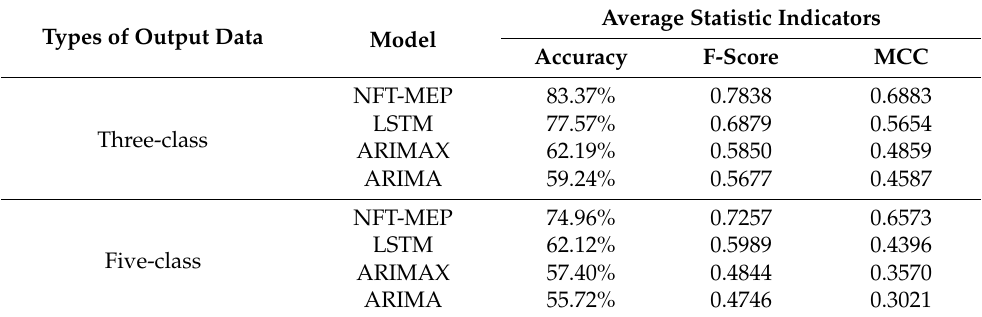
Table 7. Comparison result of four prediction models to predict hourly PM 2.5 with three and five classes of output